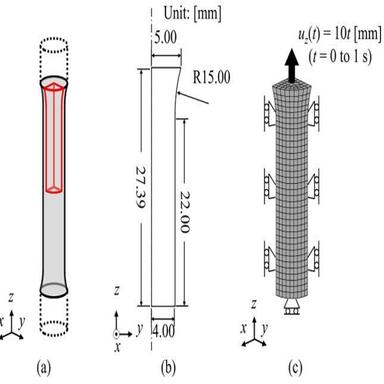
Dog-bone specimen model for the uniaxial tensile test simulations in this study. (a) One-eighth symmetrical model of the specimen except the grip sections. The red lines represent the outline of the one-eighth model. (b) Dimensions of the cross-section of the one-eighth model shown in (a). (c) Finite element meshing with 1260 hexahedral eight-node solid elements and boundary conditions.